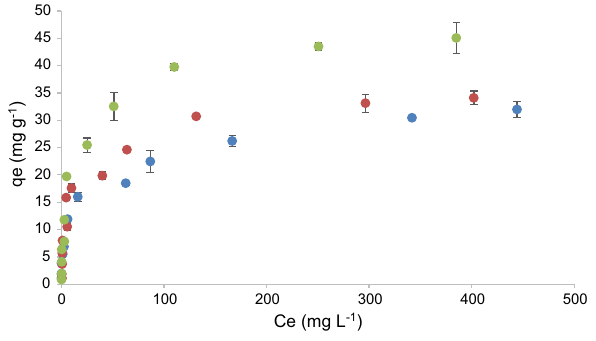
Fig. 6 Adsorption isotherm of paracetamol at temperatures of 288, 298 and 308 K Table 3 Adjustment of the Freundlich, Langmuir and Sips models for the adsorption of PAR in activated carbon